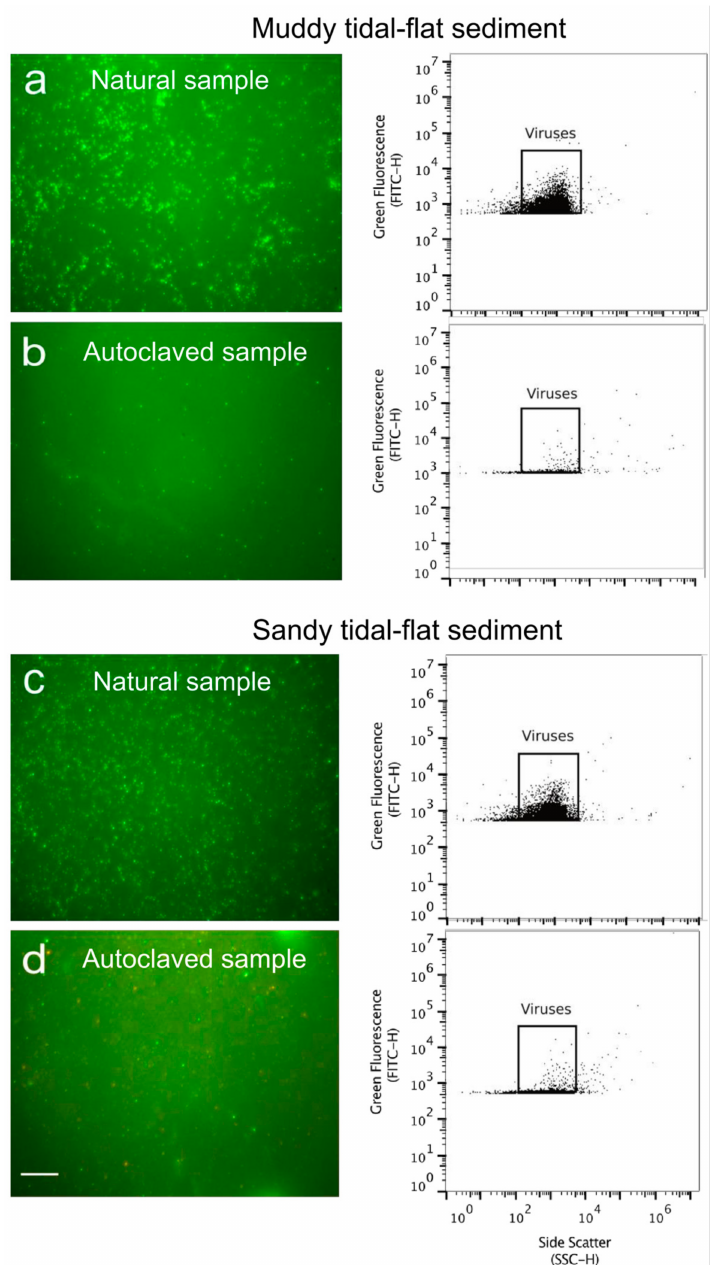
Figure 3. Epifluorescence micrographs and the corresponding cytograms of SYBR Green I stained virus particles from samples analyzed with epifluorescence microscopy (left column) and flow cytometry (right column). The samples were extracted from ( a , b ) muddy and ( c , d ) sandy tidal-flat sediment containing the natural virus population ( a , c ) and their autoclaved counterparts ( b , d ). All samples were prepared using the same dilution. Scale bar indicates 200 µ m. Cytograms were recorded by the Accuri C6 flow cytometer. The gate used for quantifying the virus numbers is indicated by the square within the